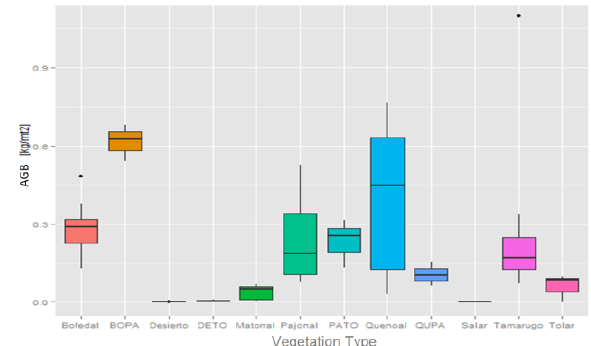
Figure 3: Boxplots of AGB in each vegetation type or land cover. Bofedal, BOPA and Salar are different kind of wetlands; Desierto means bear soil. Matorral, DETO, QUPA and Tolar are types of shrubland. Pajonal is a type of grassland; Queñoal and Tamarugo are vegetation dominated by trees.